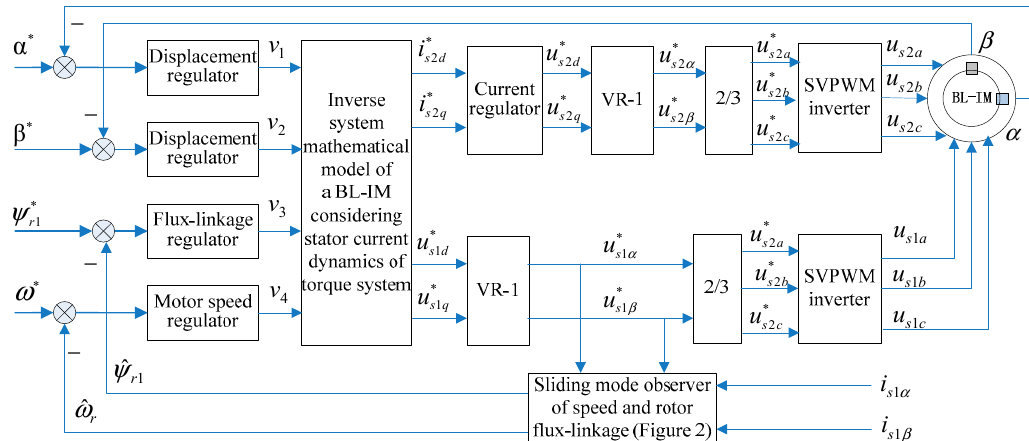
Figure 3. Schematic diagram of a bearingless induction motor (BL-IM) speed sensorless control system.